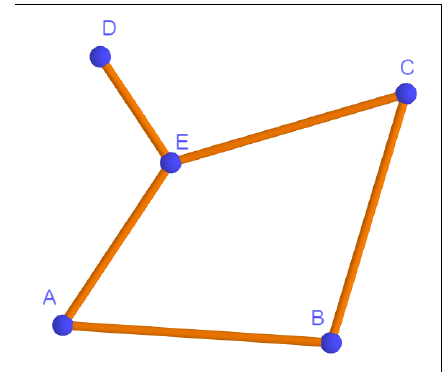
Figure 1. A linkage with 5 bars and 5